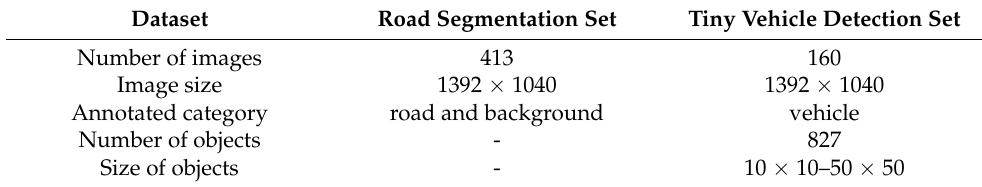
Table 1. Main information of the mid-to-high altitude UAV image dataset we